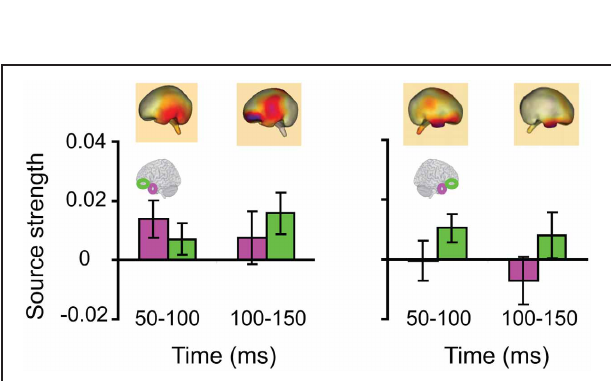
FIGURE 12 | Time-binned (50ms) semantic audio-visual integration responses (same as in Figure 11), averaged across participants, at 50–100 ms and 100–150 ms. The top panel shows L2minimum norm images from the whole-brain, which represent unconstrained localization of the group-averaged responses, for each respective time-interval. Goodness of fit =